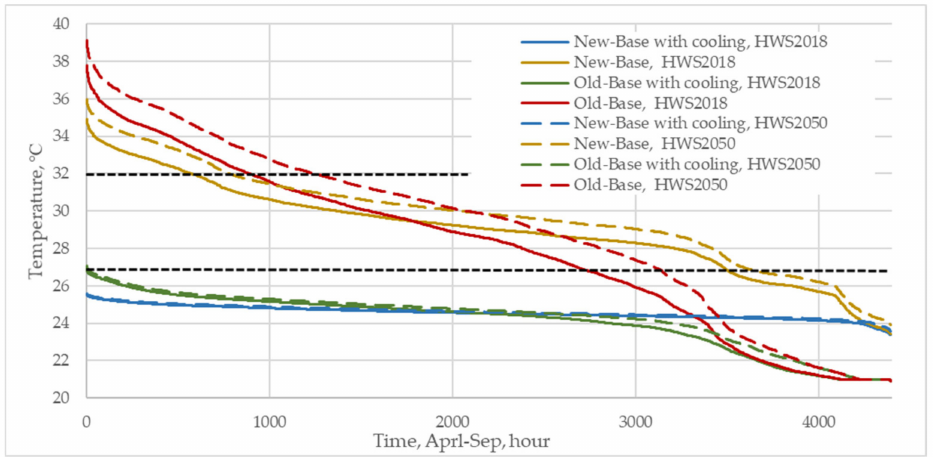
Figure 10. The April to September hourly indoor air temperature profile of the warmest bedroom, base cases, new and old building, HWS2018 and HWS2050. (The temperature levels of 27 ◦ C and 32 ◦ C are shown by black dashed lines).